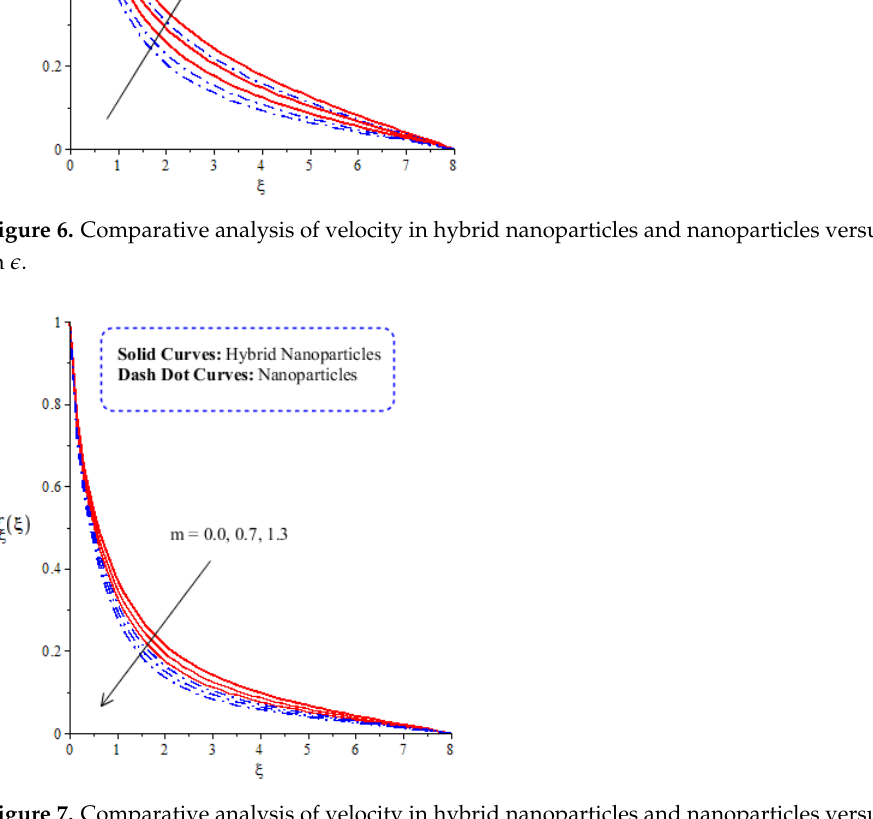
Figure 8. Comparative analysis of velocity in hybrid nanoparticles and nanoparticles versus change in 𝑅𝑒.